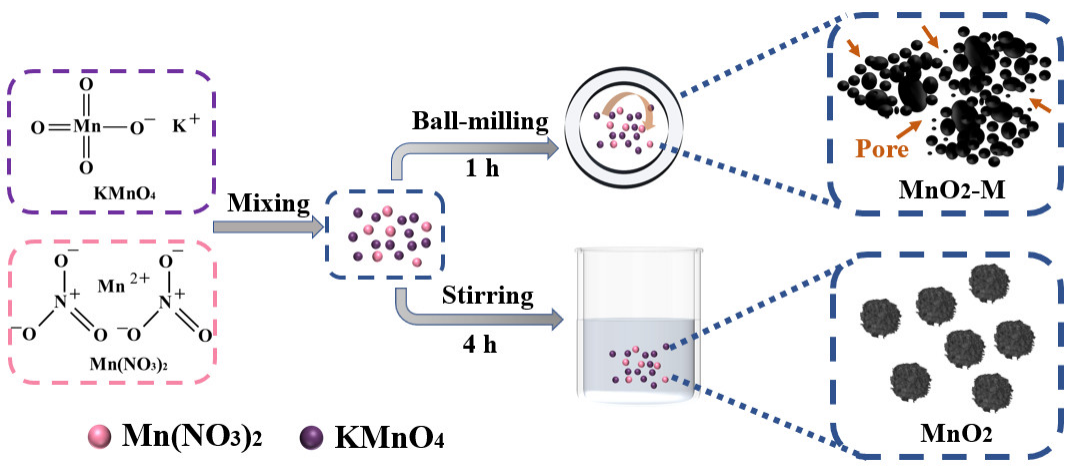
Scheme 1. Schematic illustration of the preparation of catalysts.